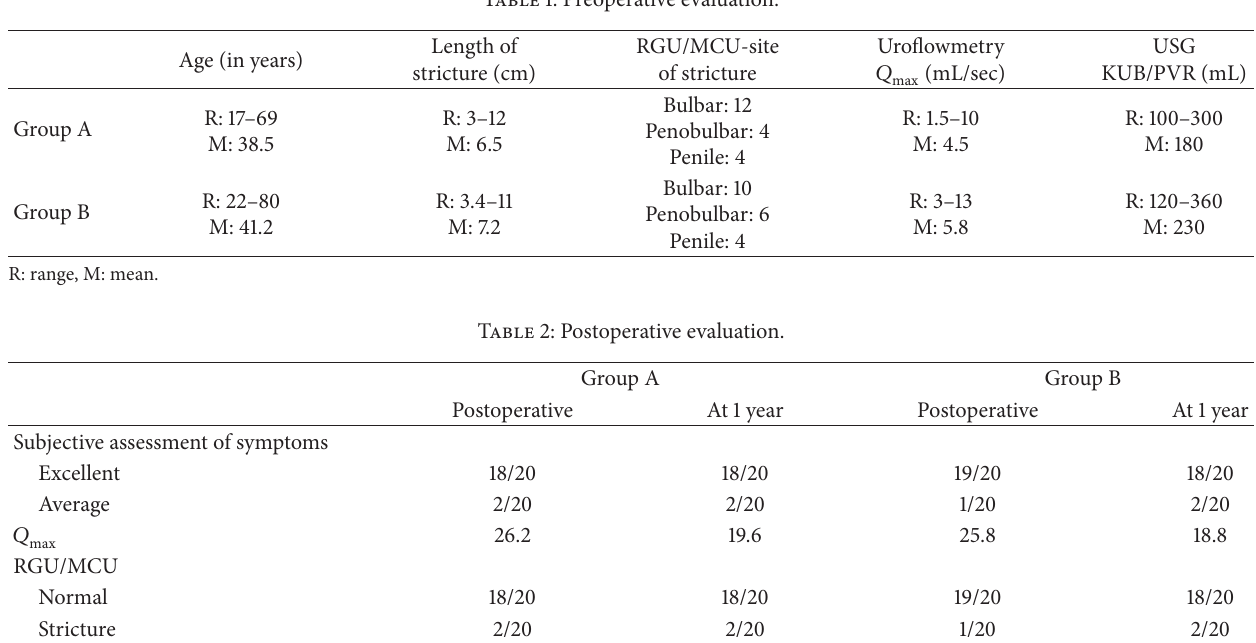
Table 1: Preoperative evaluation.